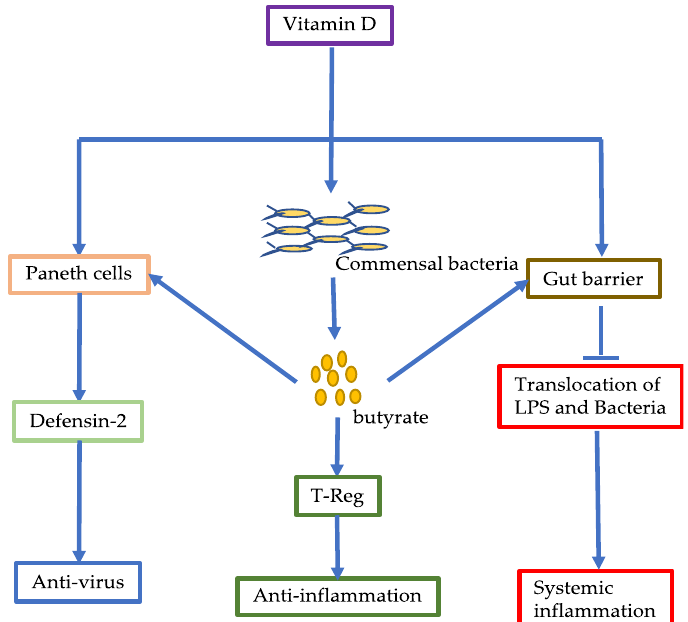
Figure 2. Effects of vitamin D on the intestinal cells, gut barrier, and gut microbiota. Vitamin D can improve gut microbiota, leading to increased production of butyrate. Butyrate can exert anti-inflammatory effects, increase gut barrier, and promote Paneth cells to secret defensin-2. Vitamin D can also directly act on gut barrier to decrease translocation of LPS and bacteria to prevent systemic inflammation. Vitamin D can also promote defensin-2 secretion by Paneth cells to increase anti-viral effect.